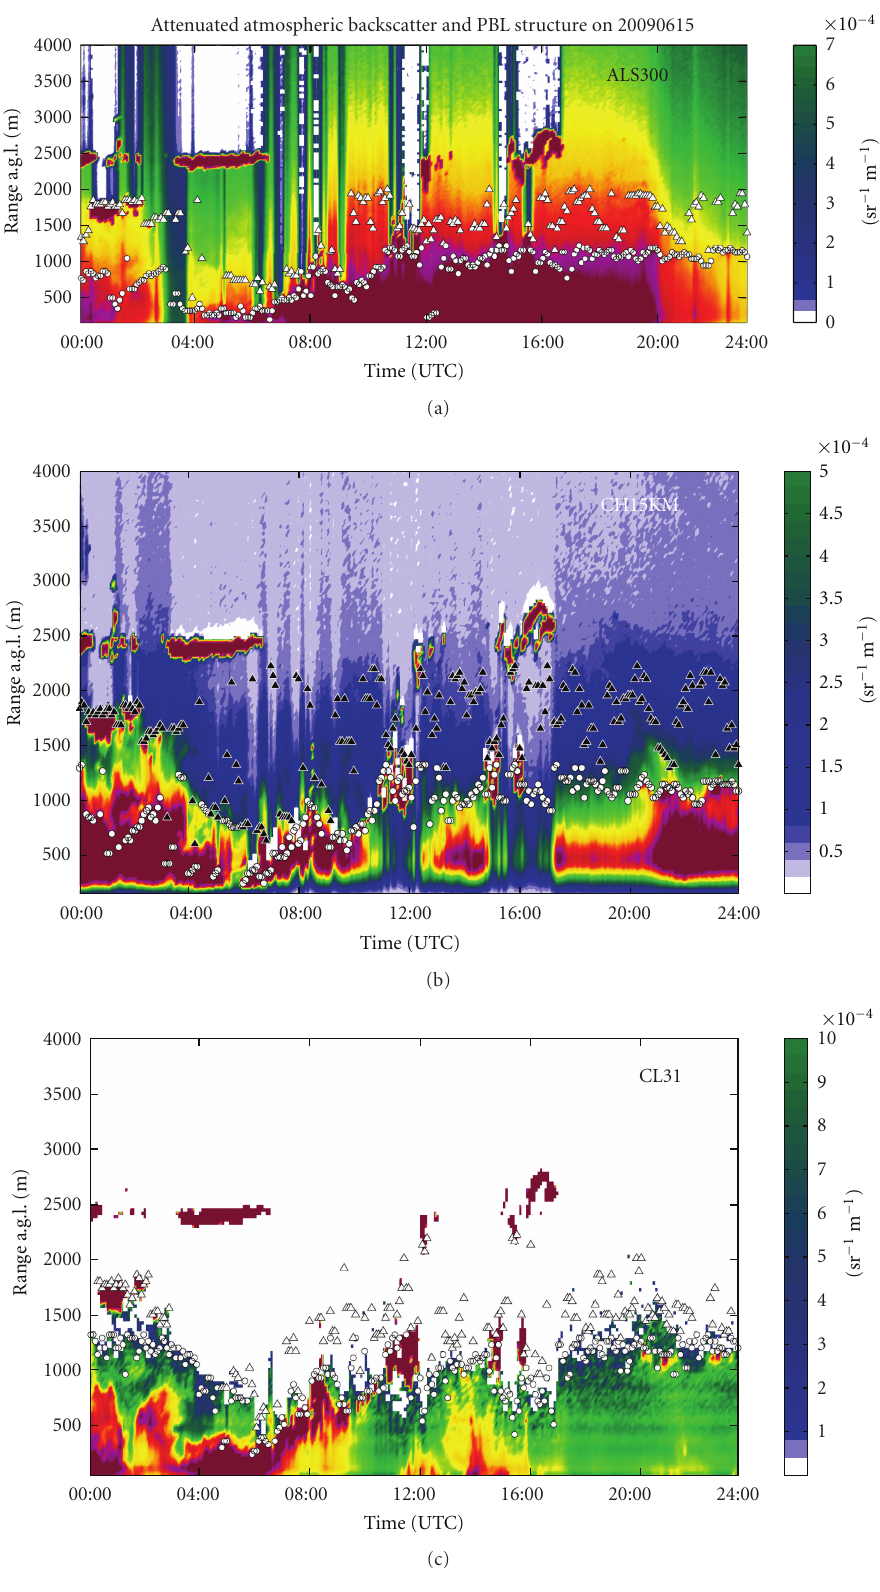
Figure 2: Time-height cross-sections of the atmospheric attenuated backscatter on the 15th of June